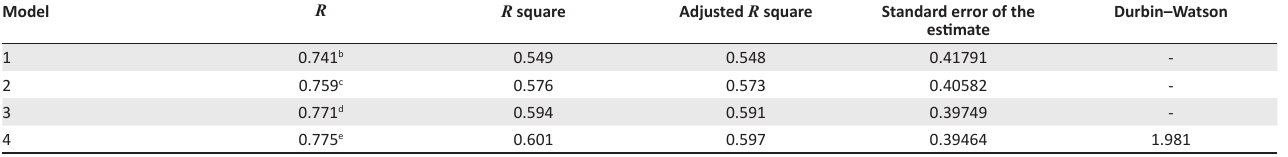
TABLE 5: Multiple regression analysis. Model summary a Model R